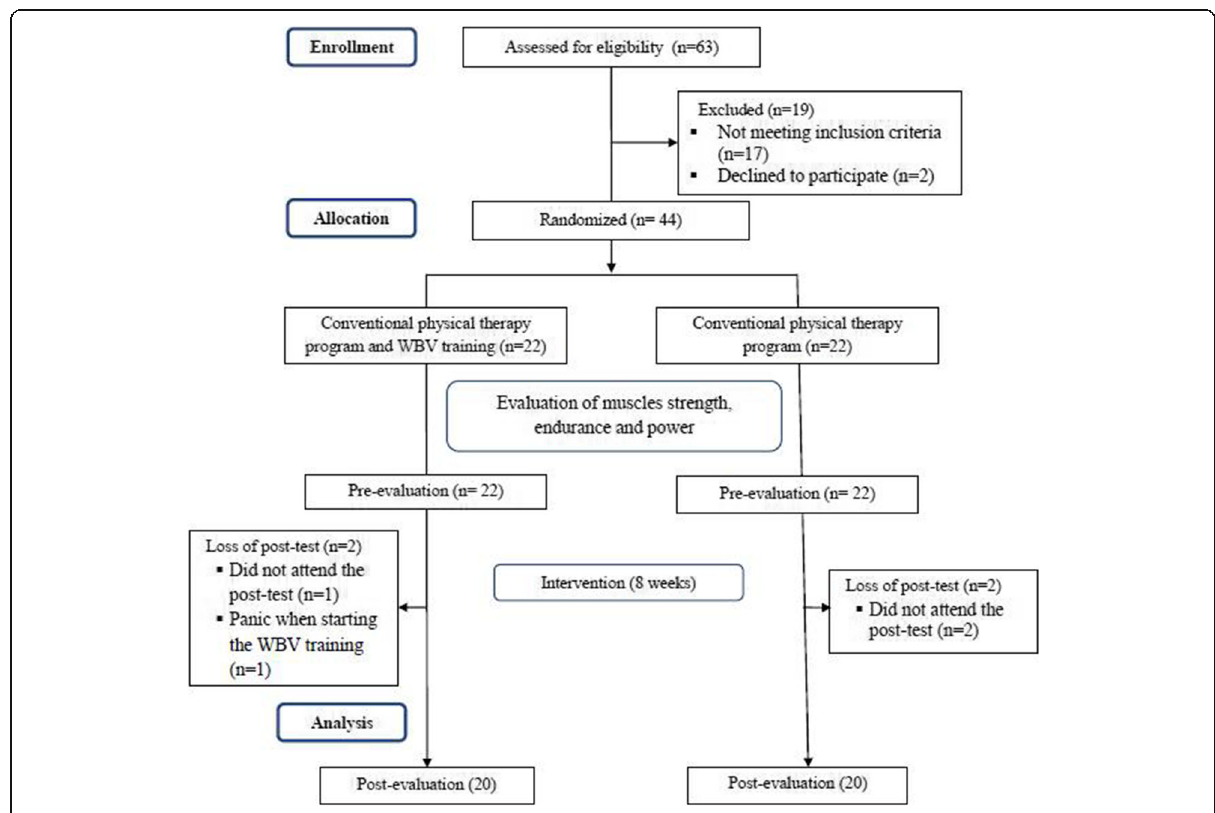
Fig. 1 Flowchart of the study processes. WBV indicates whole-body